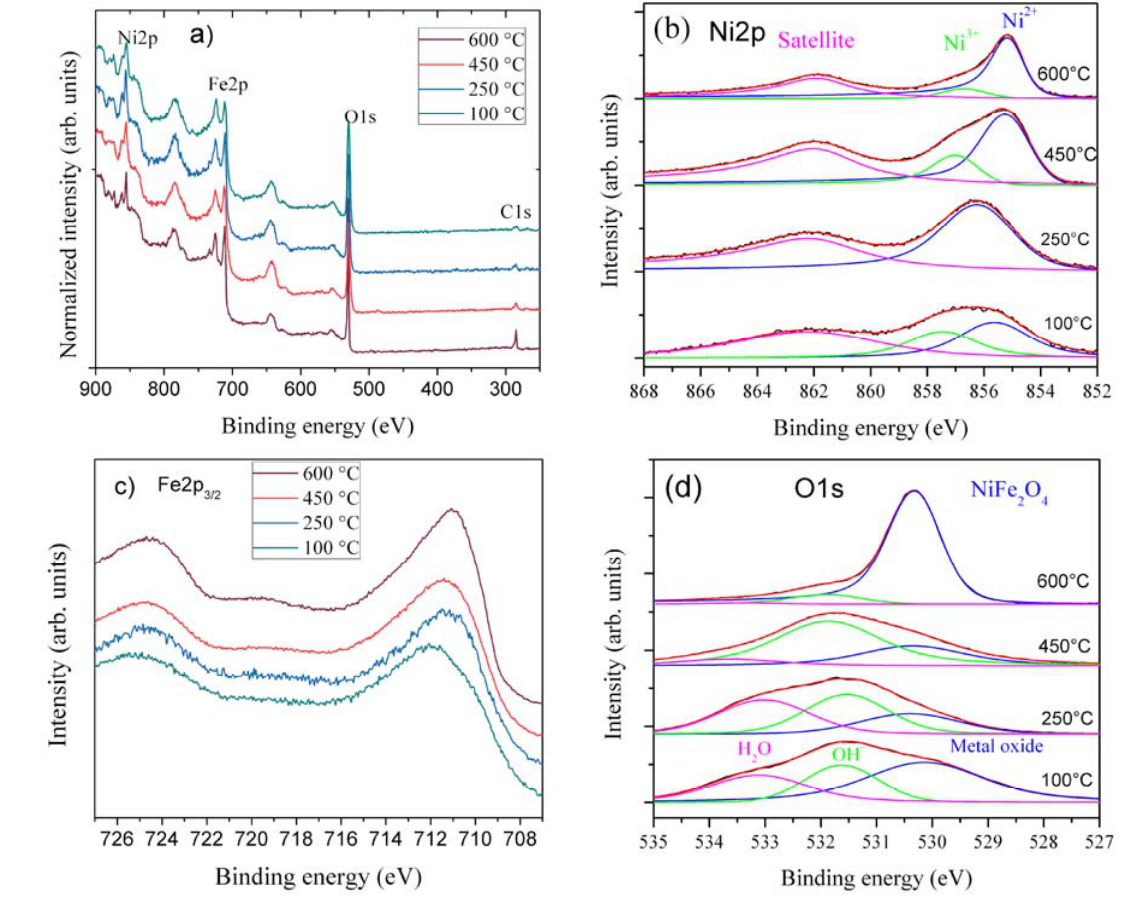
Figure 4. XPS spectra of ( a ) whole range, ( b ) Ni 2p, ( c ) Fe 2p, and ( d ) O1s energy region from 100–600 °C calcined samples.